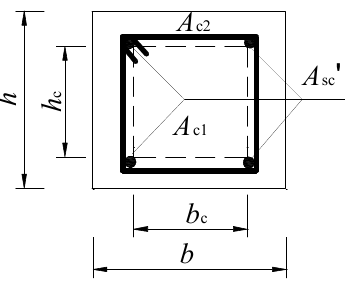
Table 4. Test results for ultimate bearing capacity.